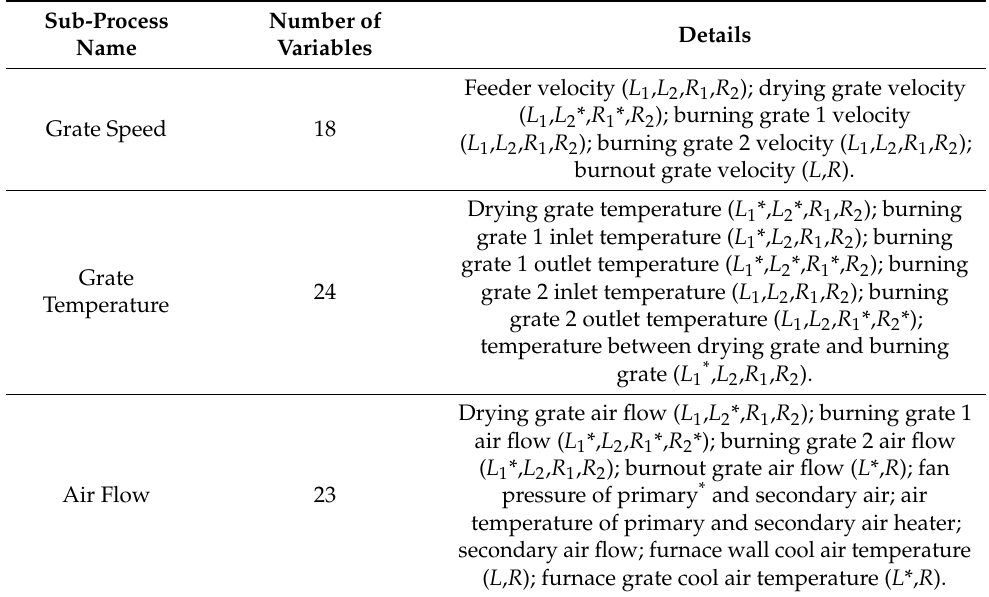
Table 1. Details of Feature